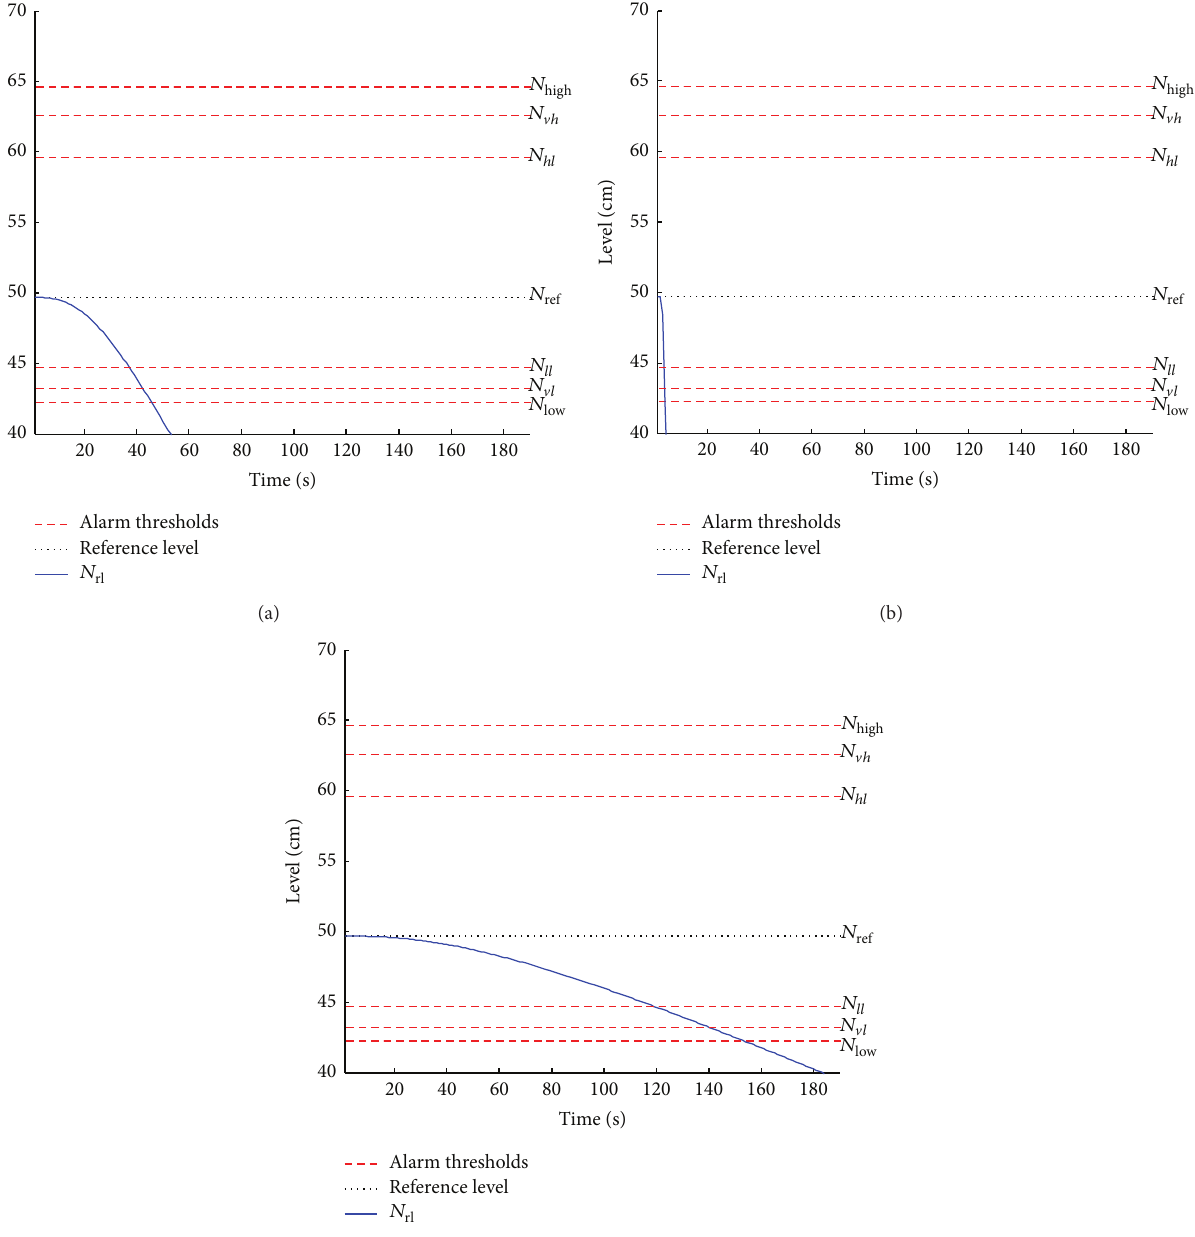
Figure 19: (a) 𝑁 evolution when the safety relief valve fails stuck with 𝑄 rl controller fails stuck at 18% of nominal 𝑄 𝑒 that should be provided at 5% 𝑃 𝑛